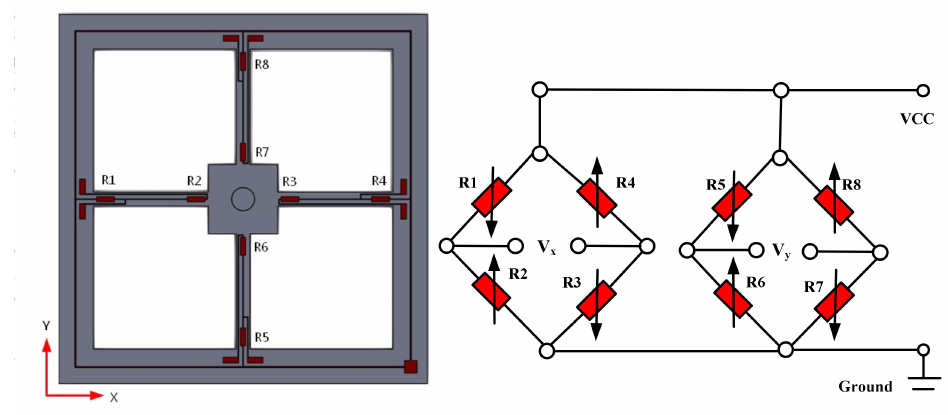
Figure 2. Wheatstone bridges.